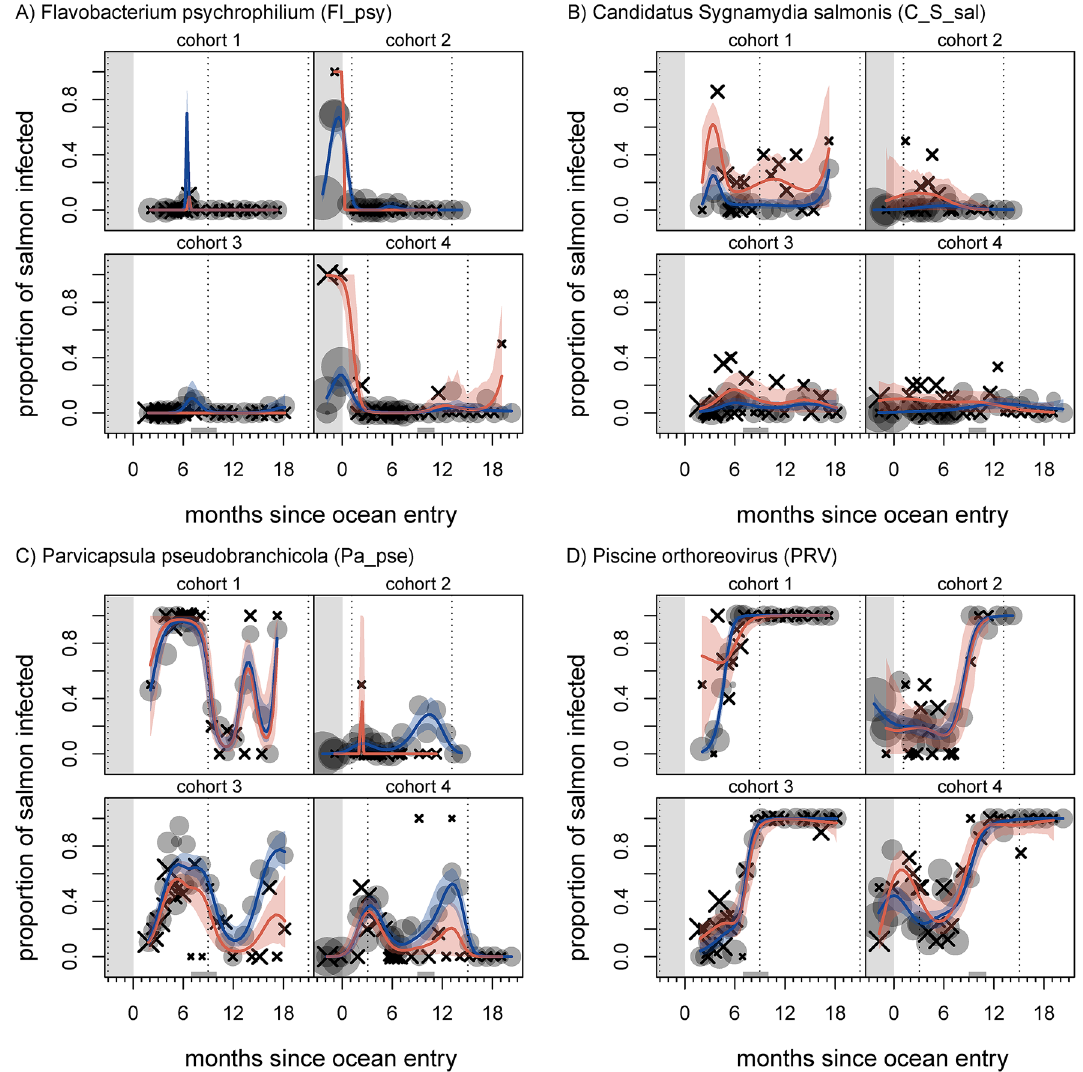
Figure 2. Agent prevalence of Flavobacterium psychrophilum (Fl_psy; A ), salmon gill chlamydia Candidatus Syngnamydia salmonis (C_S_sal; B ), Parvicapsula pseudobranchicola (Pa_pse; C ), and Piscine orthoreovirus (PRV; D ) in farmed Atlantic salmon throughout four production cycles. Grey circles show prevalence in live fish on each sampling date, and black X’s show prevalence in dead/dying fish (symbol areas proportional to sample sizes). Curves indicate mean predictions from a generalised additive model; blue and red correspond to live and dead/dying fish, respectively (shaded areas show 95% confidence regions). Left-hand grey region indicates freshwater hatchery residence, grey regions on x-axis indicate period of transfer to another site, and vertical dotted lines correspond to January